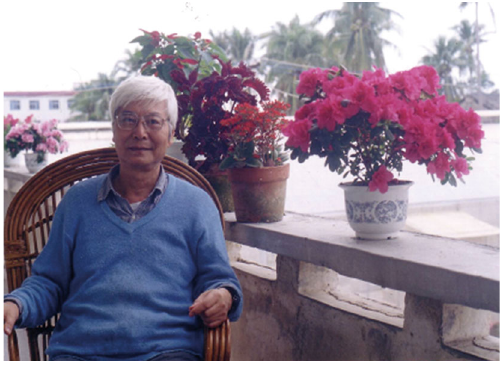
Figure 2. Professor Ruofu Du in